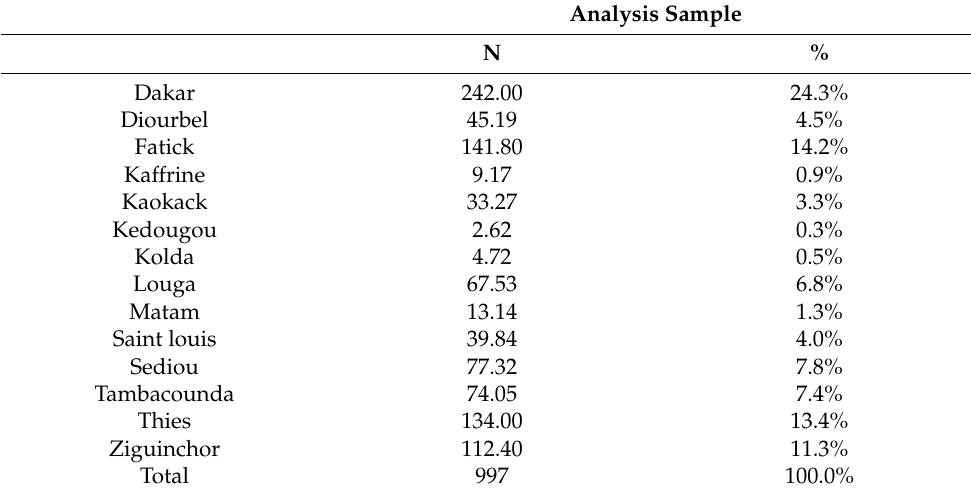
Table A4. Distribution of the Analysis Sample at the Regional Level.